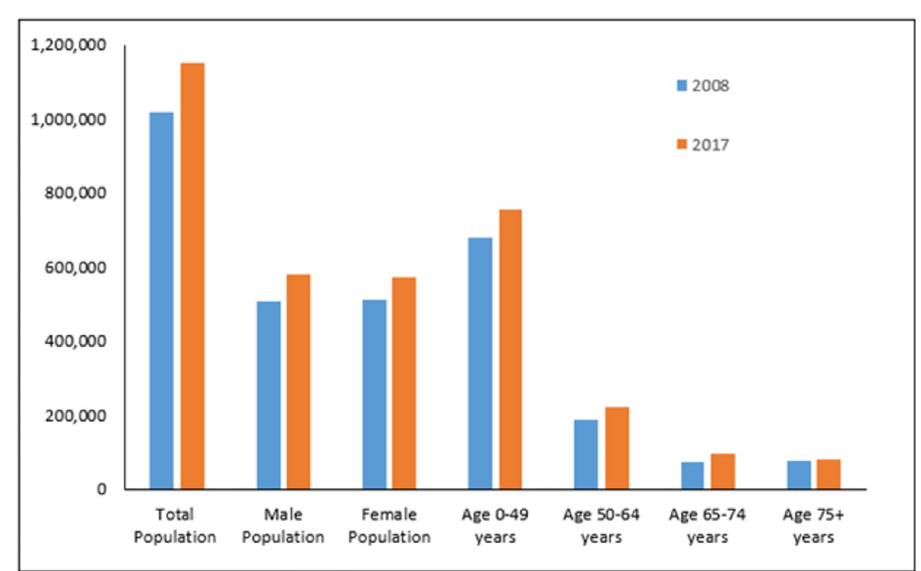
Fig 2. Comparison of population distribution between 2008 and 2017 in Saskatchewan.